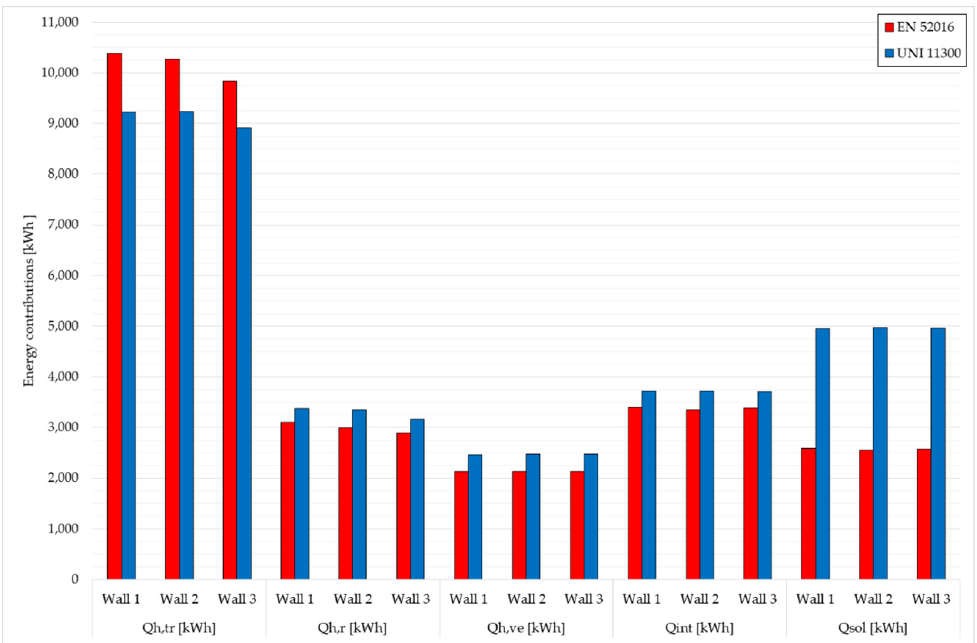
Figure 8. Energy-contribution comparison during the heating period: UNI 11300 vs. EN 52016 (Q h,tr = heat losses for transmission through the building envelope; Q h,r = extra heat flow due to thermal radiation to the sky; Q h,ve = heat losses for ventilation; Q int = internal heat gains; Q sol = solar radiation through windows).